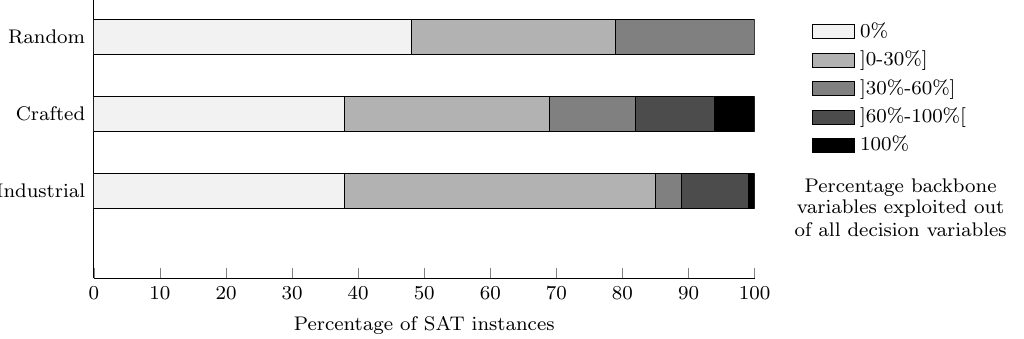
Figure A8. Percentage number of exploited backbones by MapleLCMDistChronoBT-DL-v3 for the first 1000 decisions on all 2002–2020 benchmark